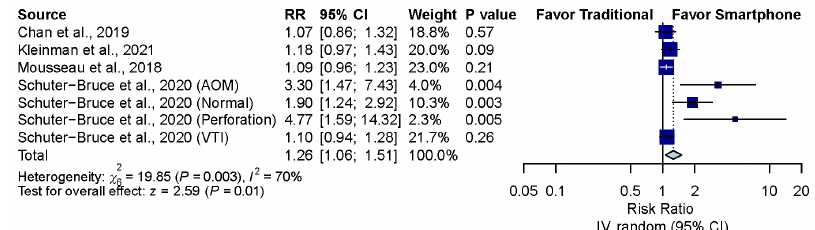
Figure 3. Overall comparison between smartphone-enabled otoscopy and traditional otoscopy.